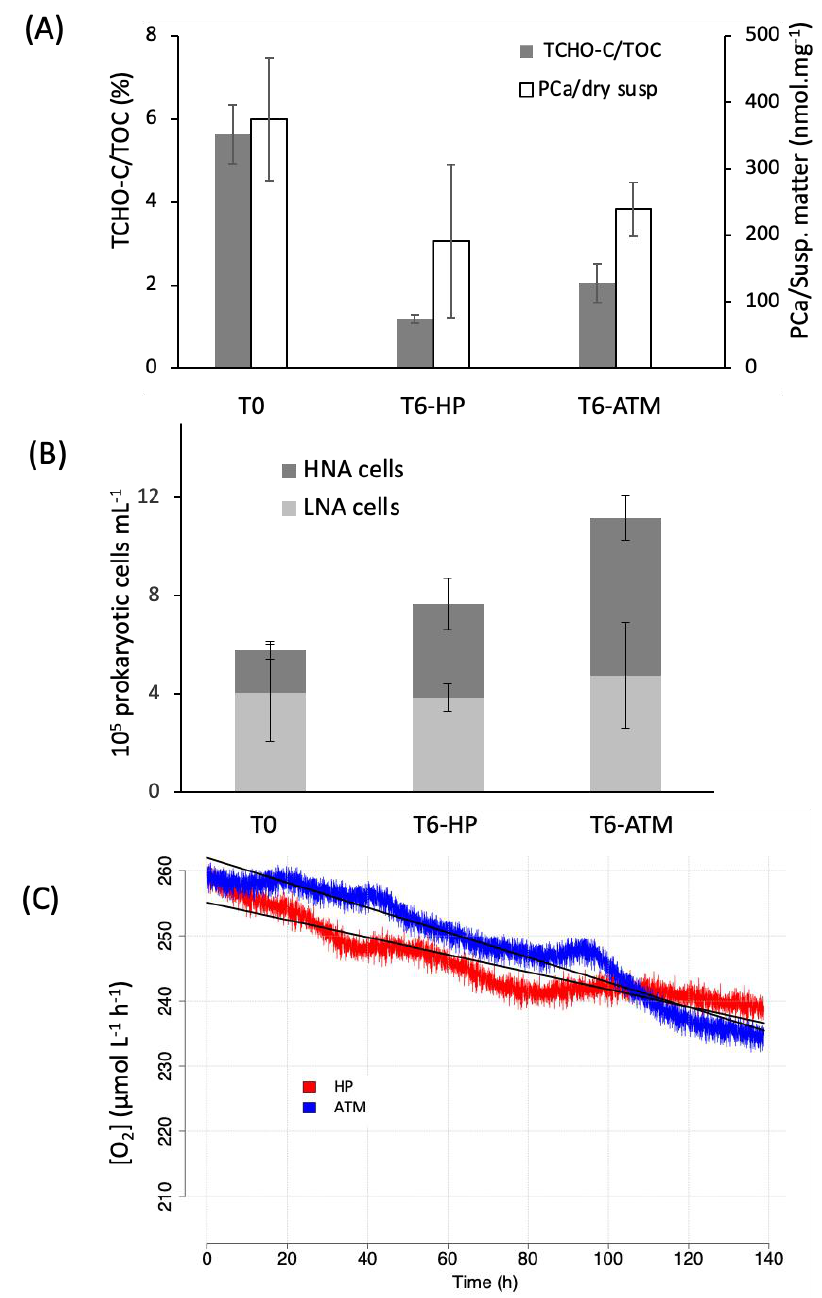
Figure 2. ( A ) Ratio of total carbohydrates (TCHO-C) versus total organic carbon (TOC) (left axis) and between particulate calcium and suspended matter (PCa/Susp.) expressed in nmol mg −1 (right axis) initially (T0) and after 6 days of incubation under increasing pressure (T6-HP) or atmospheric pressure (T6-ATM) conditions. Error bars display the standard deviation of the duplicates in both incubation conditions. ( B ) Prokaryotic abundance initially (T0) and after 6 days of incubation at HP and ATM conditions. LNA (light gray) are cells with low nucleic acid content, HNA (dark gray) are cells with high nucleic acid content. Total cells correspond to the sum of LNA and HNA cells. Error bars display the standard deviation of the duplicates in both incubation conditions. ( C ) Real-time measurements of the total O 2 consumption under conditions of increasing pressure (HP, red line) and atmospheric conditions (ATM, blue line). Black lines correspond to the linear regression used to calculate oxygen consumption rates; HP: − 0.13 ± 0.0005 µM O 2 L −1 h −1 , R 2 = 0.90; ATM: −0.19 ± 0.0005 µM O 2 L −1 h −1 , R 2 = 0.96.